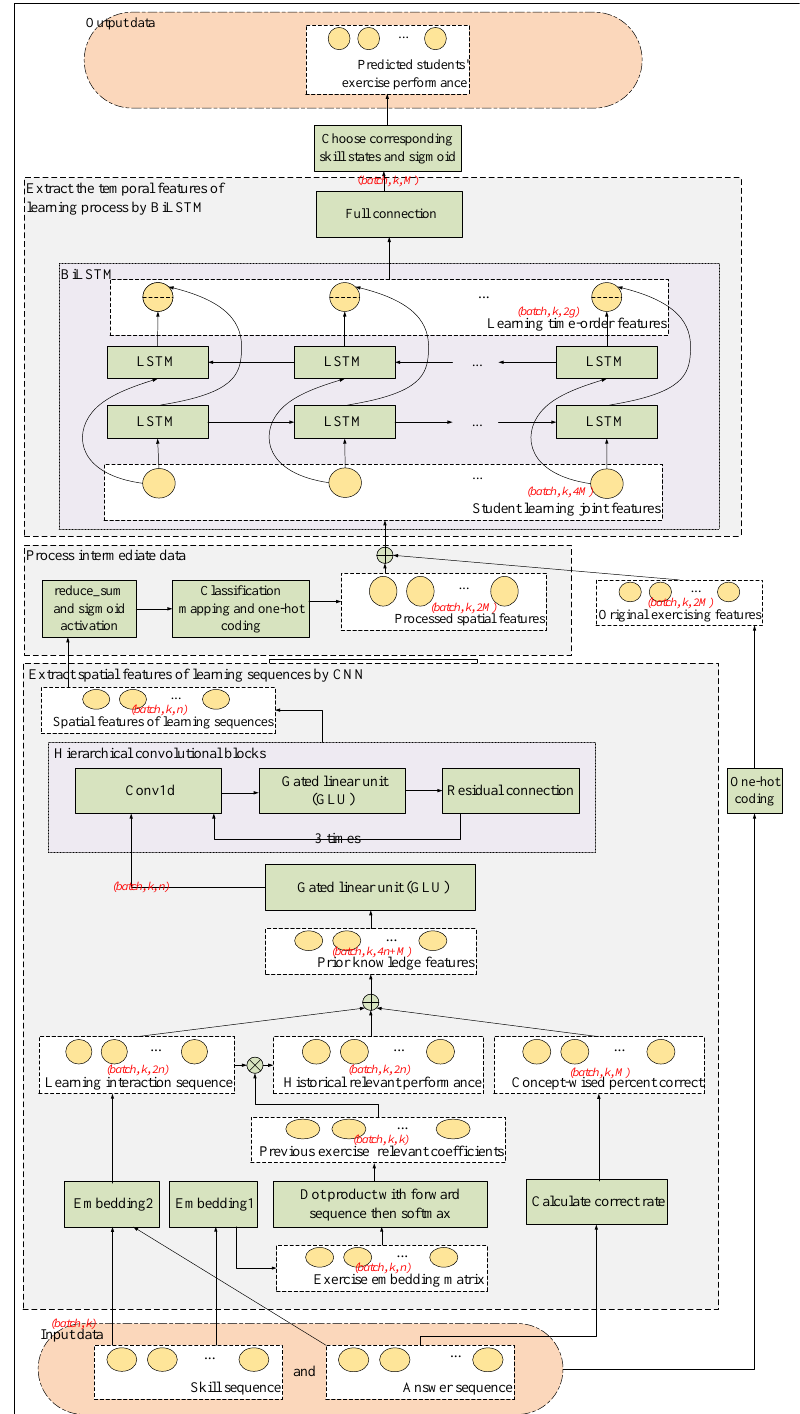
Figure 1. The architecture of the DKT-STDRL model. The red text in the figure shows the shape of the data, where batch equals the batch size. k represents the max sequence length. n is the number of dimensions of the embedding matrix. M is the count of different skills. g is the number of units of each LSTM